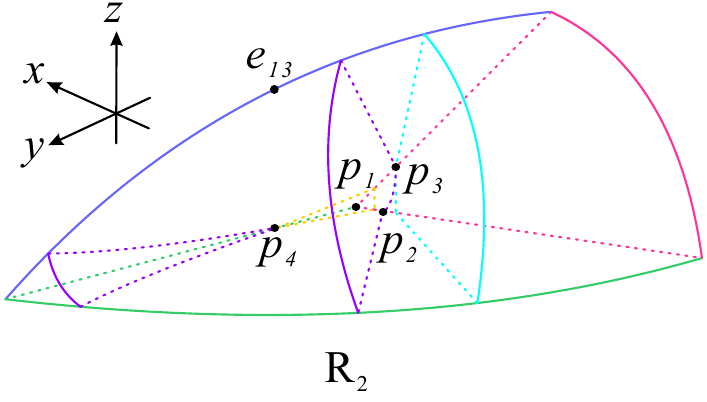
Figure 4. The purple surface is b 1 = 0, the yellow plane is b 2 = 0, and the light blue plane is b 3 = 0.